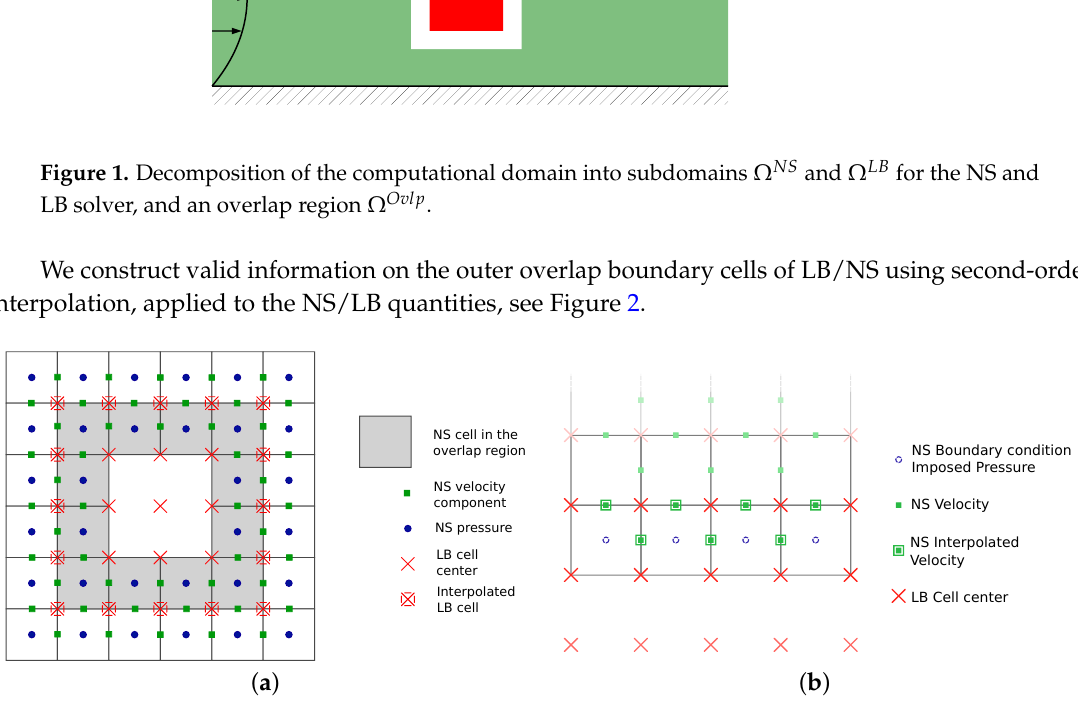
Figure 2. Grids and interpolation rules. ( a ) Interpolation of LB values. The outer red-colored nodes correspond to the LB boundary layer. The surrounding NS values in- and outside the (gray-colored) overlap region are used to interpolate density, velocity and shear stresses on these LB nodes; ( b ) Interpolation of NS values. The LB nodes marked as red crosses are used to interpolate the velocity values at the marked green locations of the staggered NS